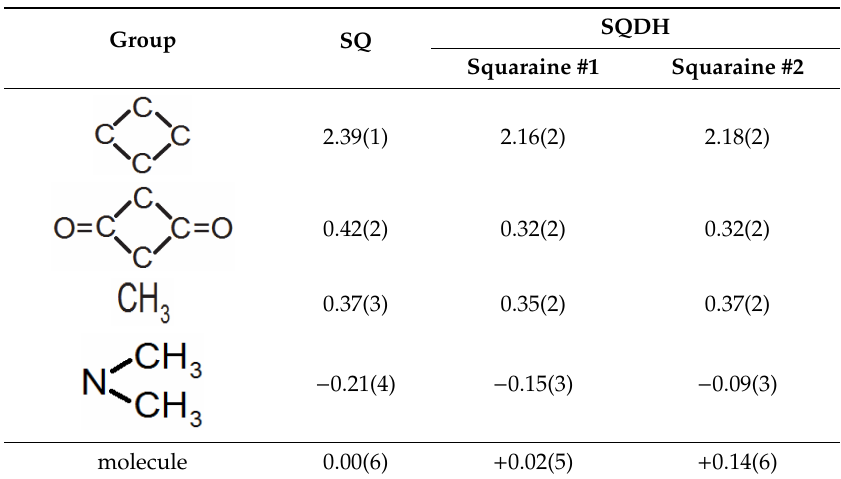
Table 8. Experimental Group Charges (electrons) of the squaraine molecules in SQ and SQDH crystals from QTAIM partitioning of the electron density. a Esds on the last significant digit are in